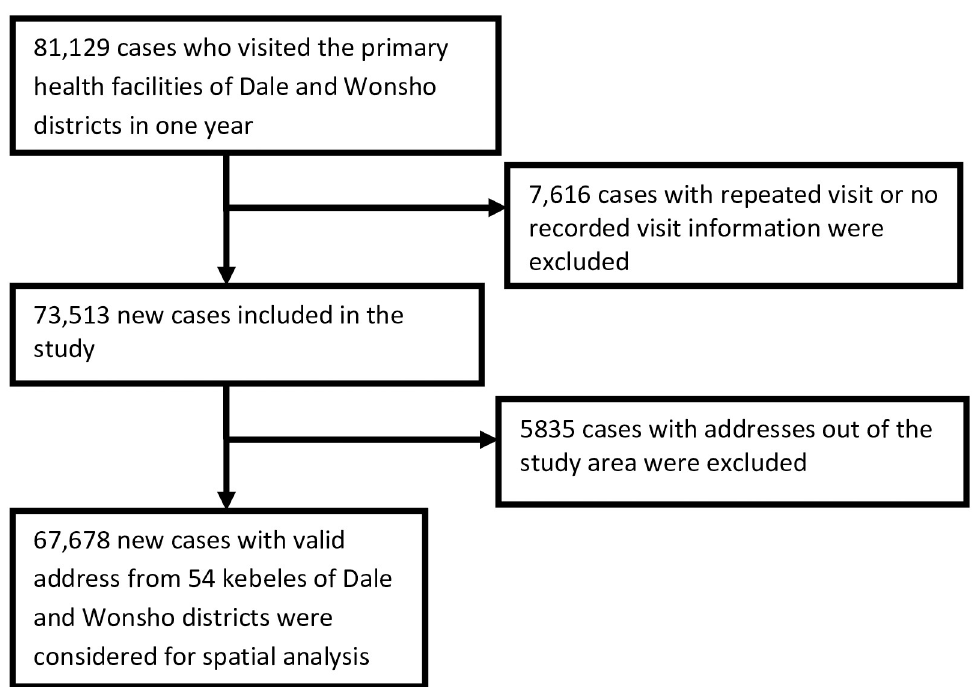
Fig 1. A flow-chart of number of cases included for the spatial analysis in Dale and Wonsho districts, 2017/18, Sidama, Ethiopia.